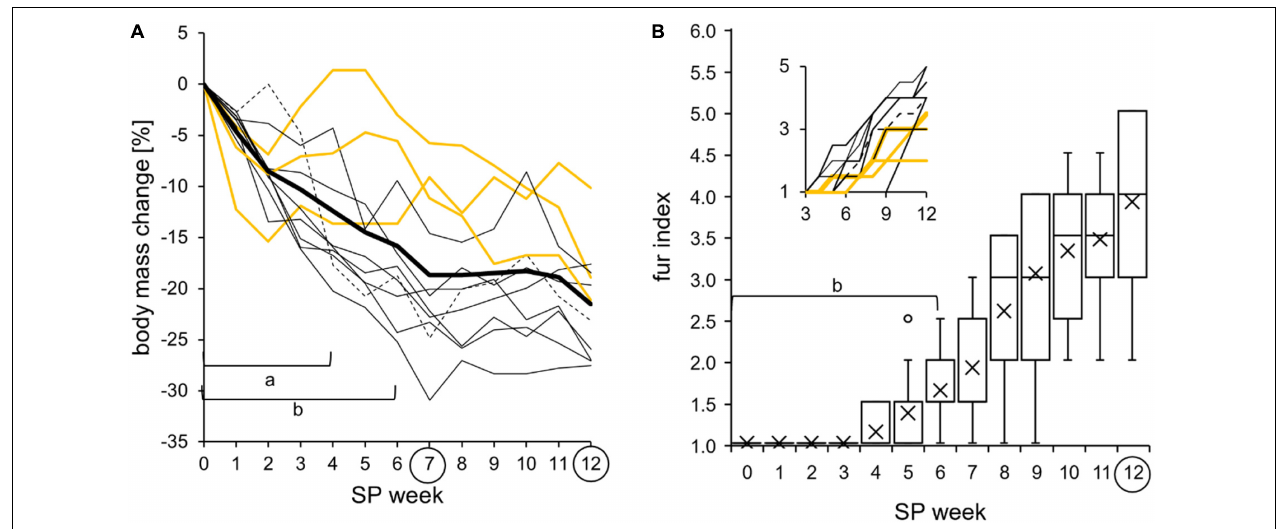
FIGURE 11 | Body mass change and molt into a white winter fur during the short photoperiod adaptation of approach 2 ( n = 11). The exact values per hamster can be found in Supplementary Table 8 . (A) Relative body mass change with the long photoperiod (LP) as baseline. The cohort’s significant differences of the relative body mass change ( thick line ) to SP07 are indicated with “ a ” e.g., to SP12 with “ b ” [one-way repeated measures ANOVA: F ( 12 , 120 ) = 28.777, p < 0.001, with Holm–Sidak p < 0.001]. All hamsters changed their body mass during the short photoperiod (SP) adaptation (hamster #06 as dotted line , the three “never torpor” hamsters as yellow lines , and all others as thin black lines ). (B) Fur index from 1 for summer fur to 6 for winter fur. The cohort’s significant differences of fur index ( boxplots ) to SP12 are indicated with “ b ” [Friedman repeated measures ANOVA: χ 2 ( 12 ) = 122.375, p < 0.001, with Tukey’s test p < 0.05]. All hamsters increased their fur index. Inset : graph with color code of graph (A)